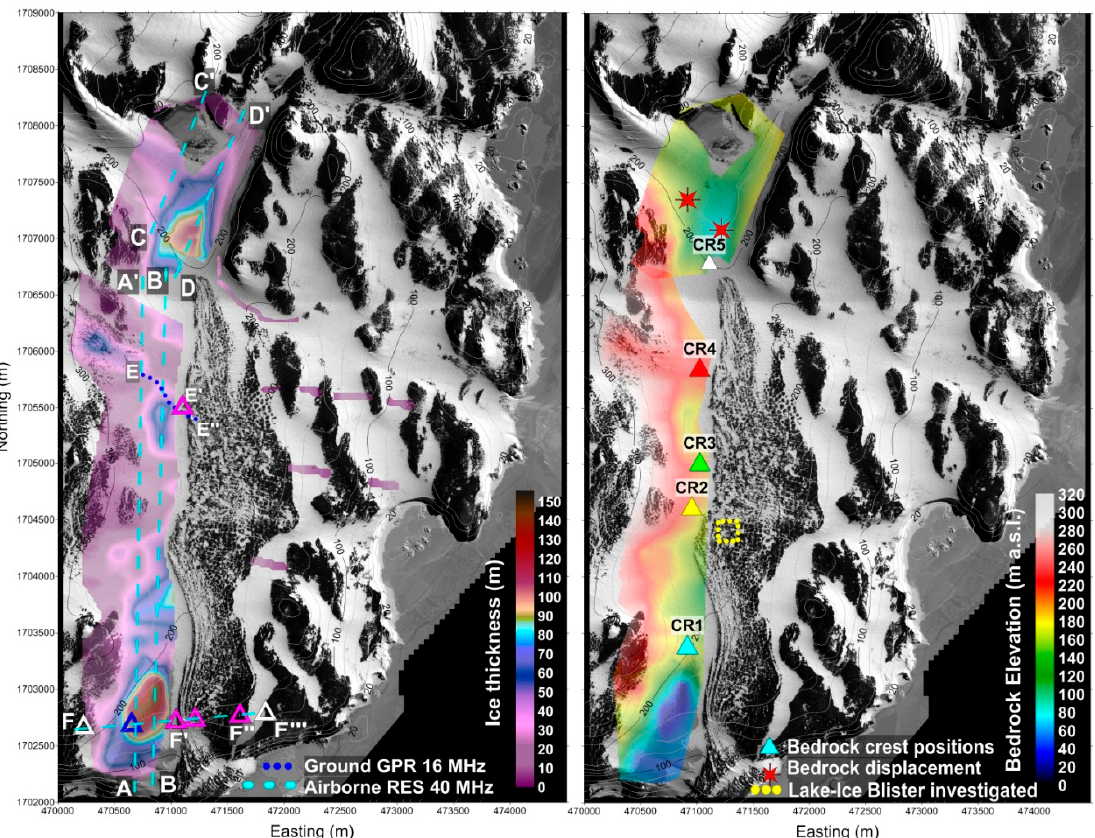
Figure 7. Map of ice thickness values interpolated along the Ground Penetrating Radar (GPR) profiles in the Boulder Clay Glacier area and derived bedrock elevation map.